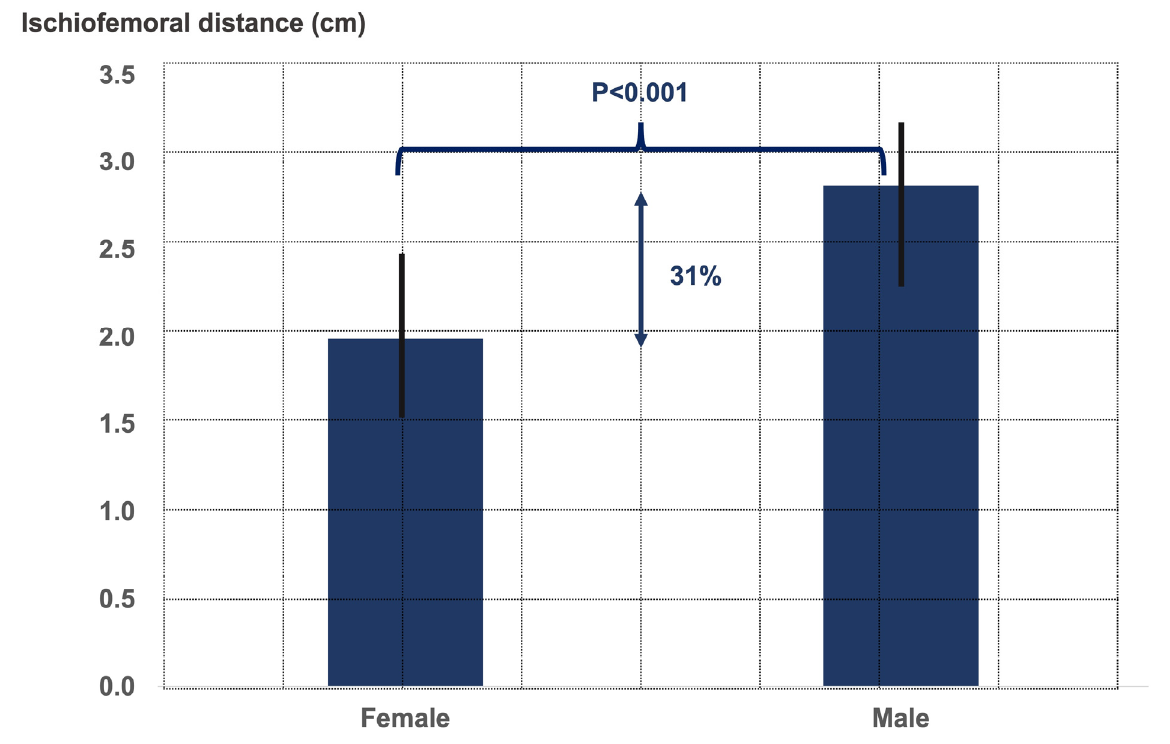
Figure 2. Graph illustrating the ischiofemoral distance in males and females.